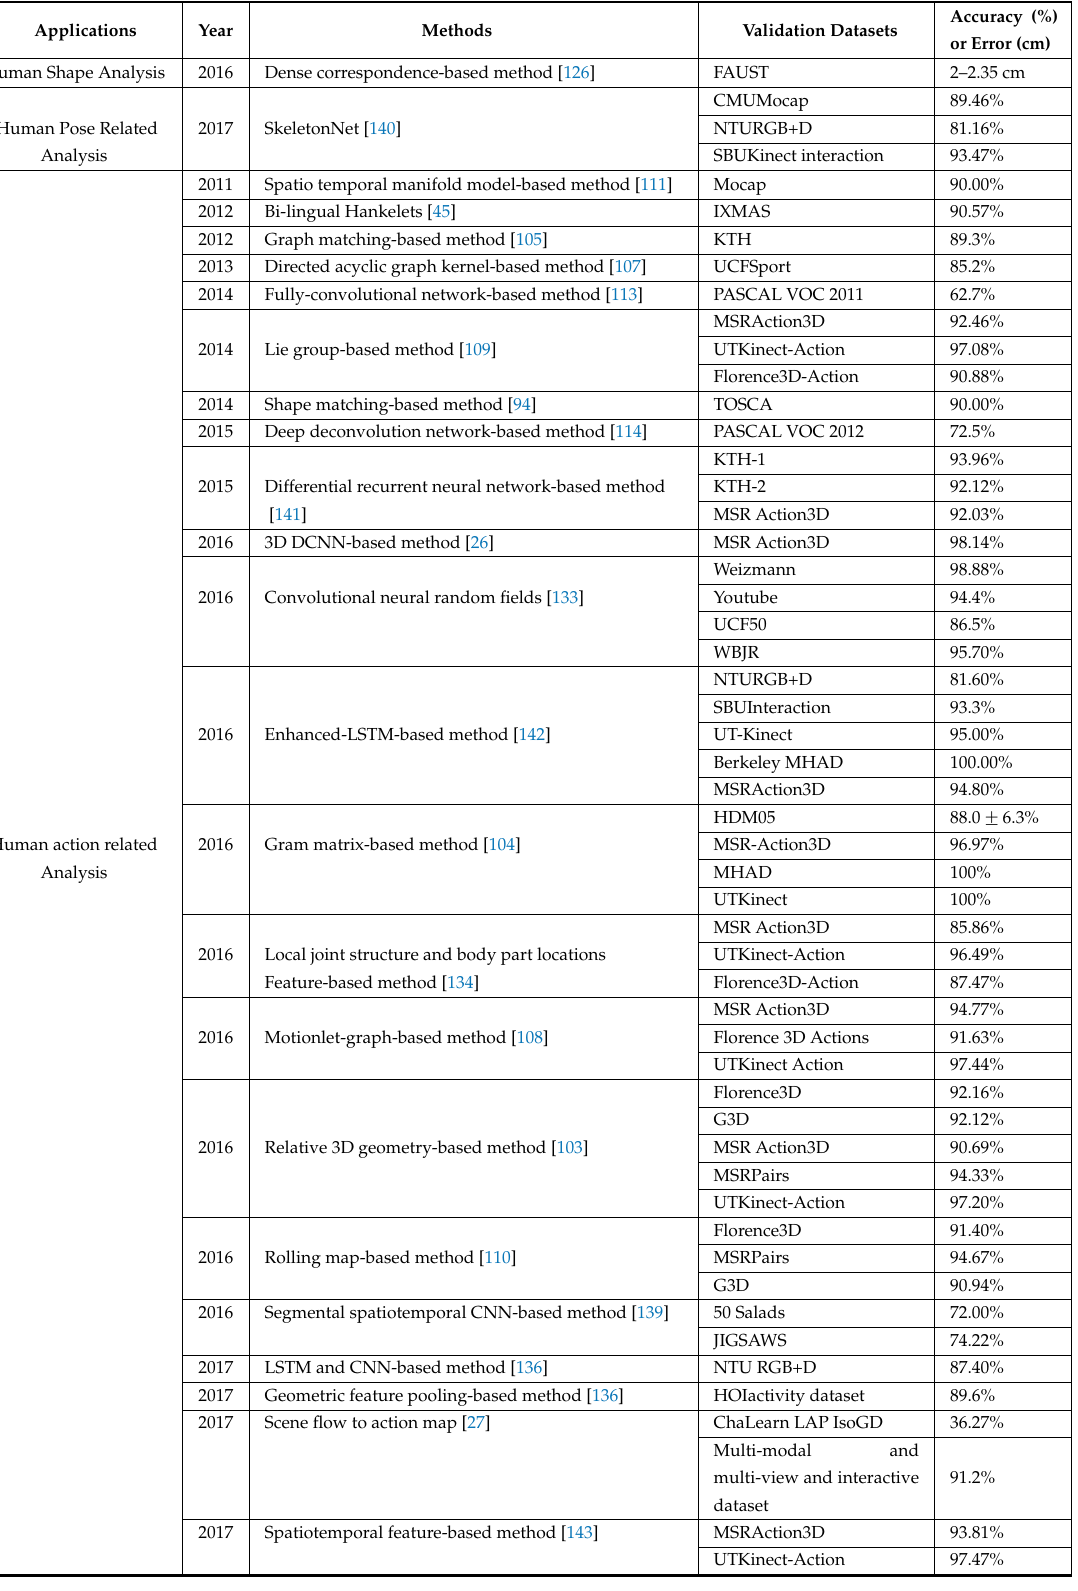
Table 1. Evaluation comparisons of geometric